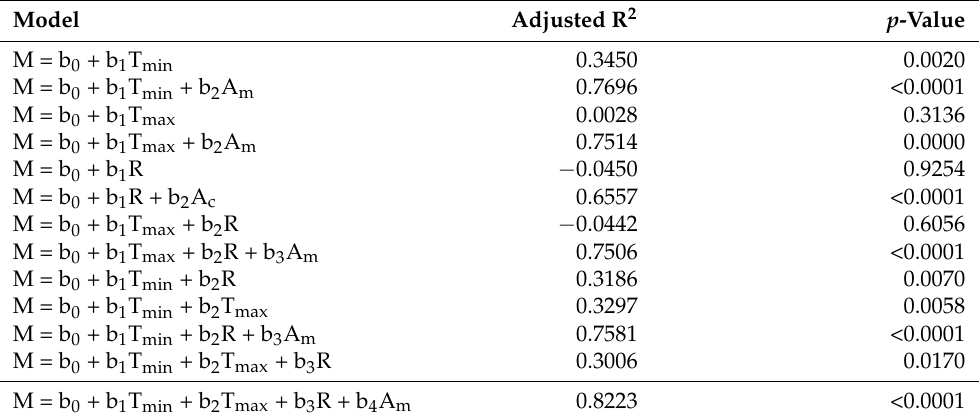
Table 2. Adjusted R 2 values for all possible linear regression models for maize production.